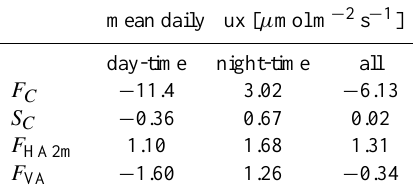
Table 1. Mean daily fluxes of EC fluxes ( F C ) , storage term ( S C ) , drainage horizontal advection ( F HA2m ) and vertical advec- tion ( F VA ) for the period May to August 2007. Day-time was de- fined as 06:00–18:00CET, night-time as 19:00–05:00CET.